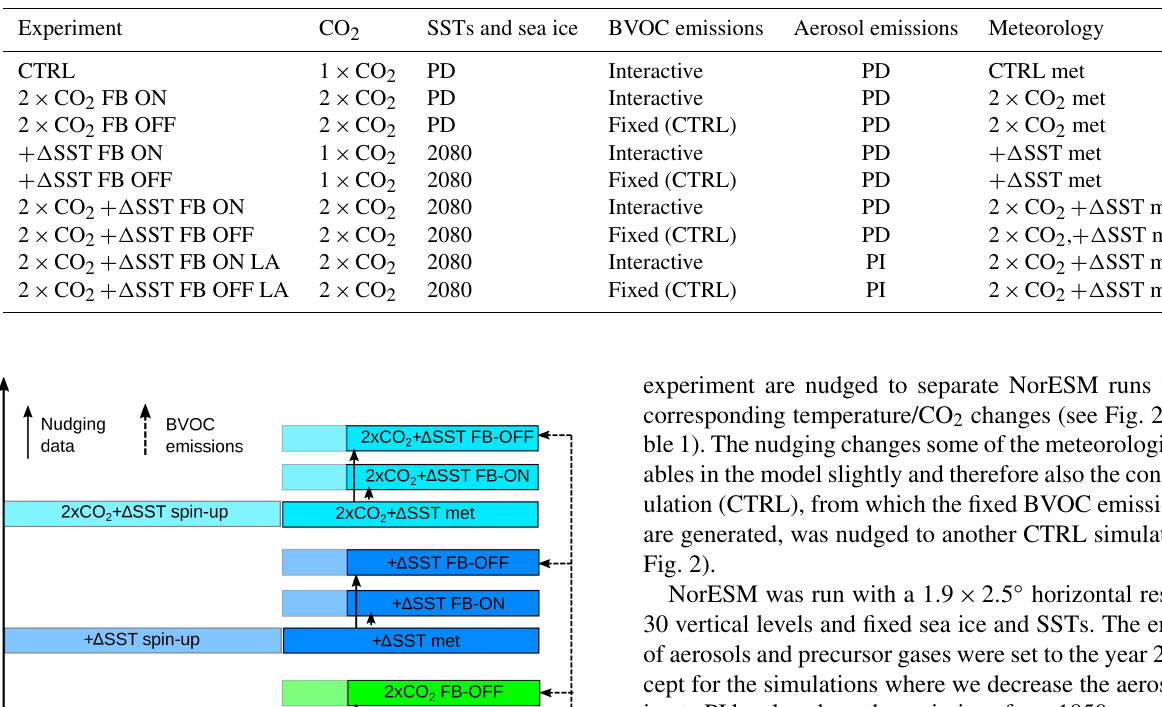
Table 1. Specifications of the CO 2 levels, year of the SSTs, BVOC emissions and which meteorology was used for the nudging for each of the simulations. “Met” stands for meteorology and refers to the simulations denoted by met in Fig. 2.